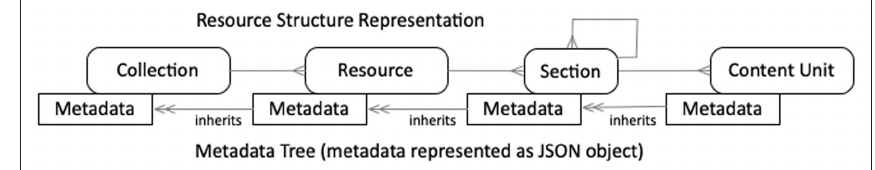
Figure 1: A schematic representation of the SHINE resource representation model.